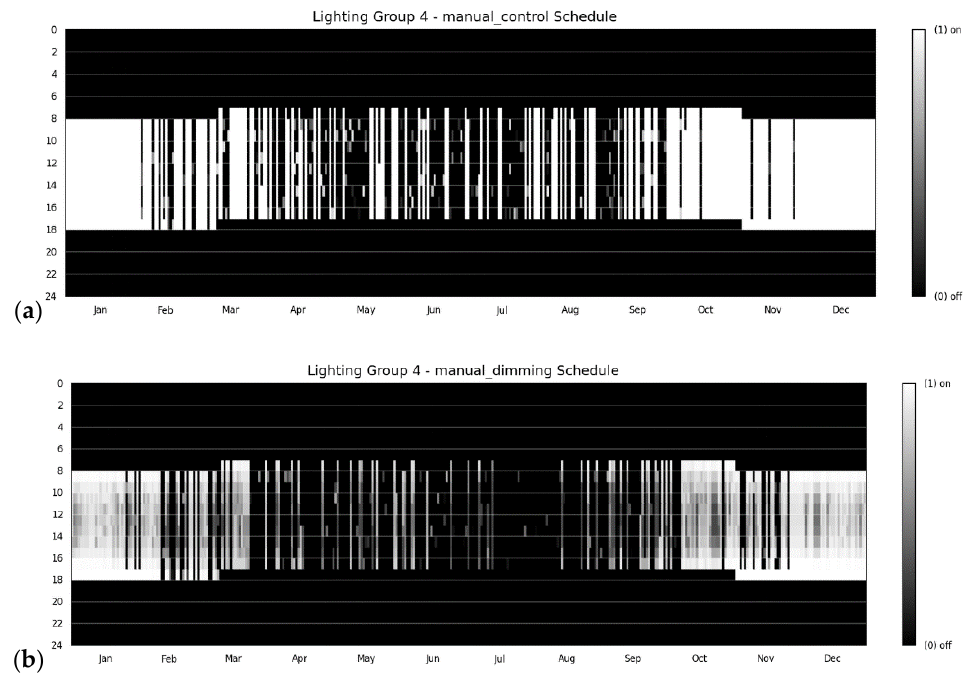
Figure 6. Operation of the control modes as an example: ( a ) on/off (o/o) in No. 4; and ( b ) dimming in No. 16.